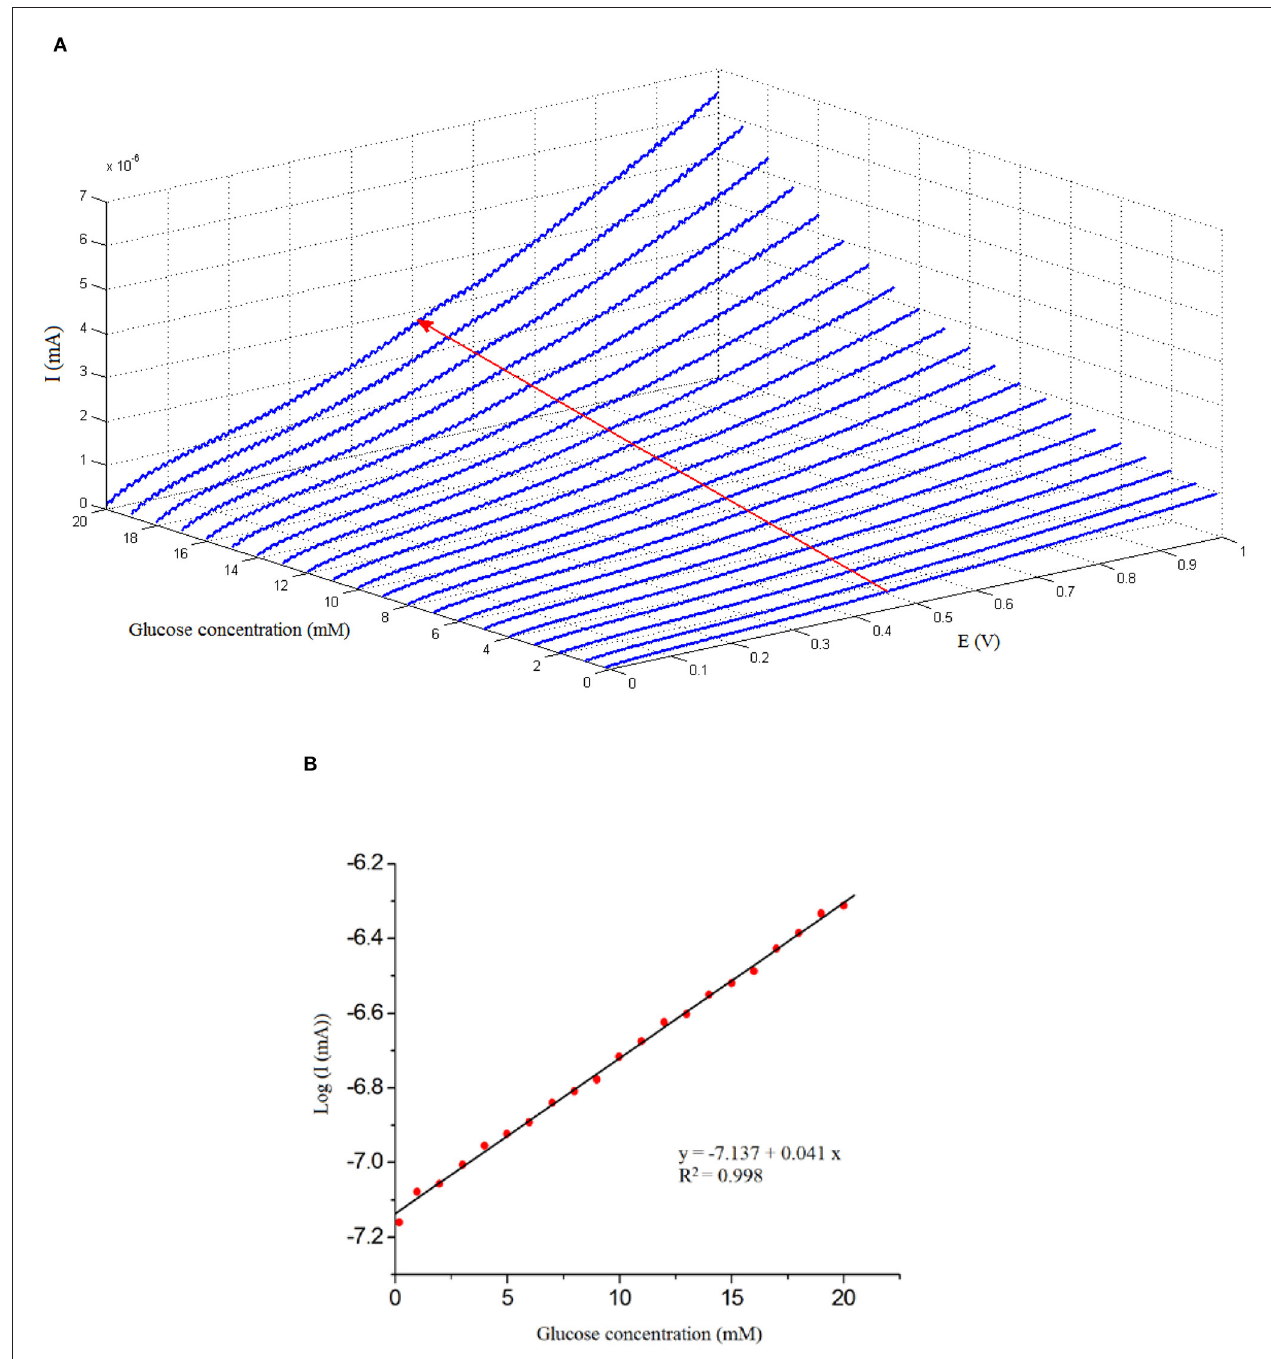
FIGURE 7 | (A) Current–voltage ( I - V ) plots obtained on the GOx/nano-ZnO/polyvinyl alcohol (PVA)/fluorinated tin oxide (FTO) biosensor in the presence of different concentrations of glucose: 0.2–20mM with a rate of 0.1 V/s. (B) Variation of I - V plots current as a function of glucose concentration, at E = 0.5V, which represents the calibration curve ( y = − 7.137 + 0.041 x , R 2 = 0.998).